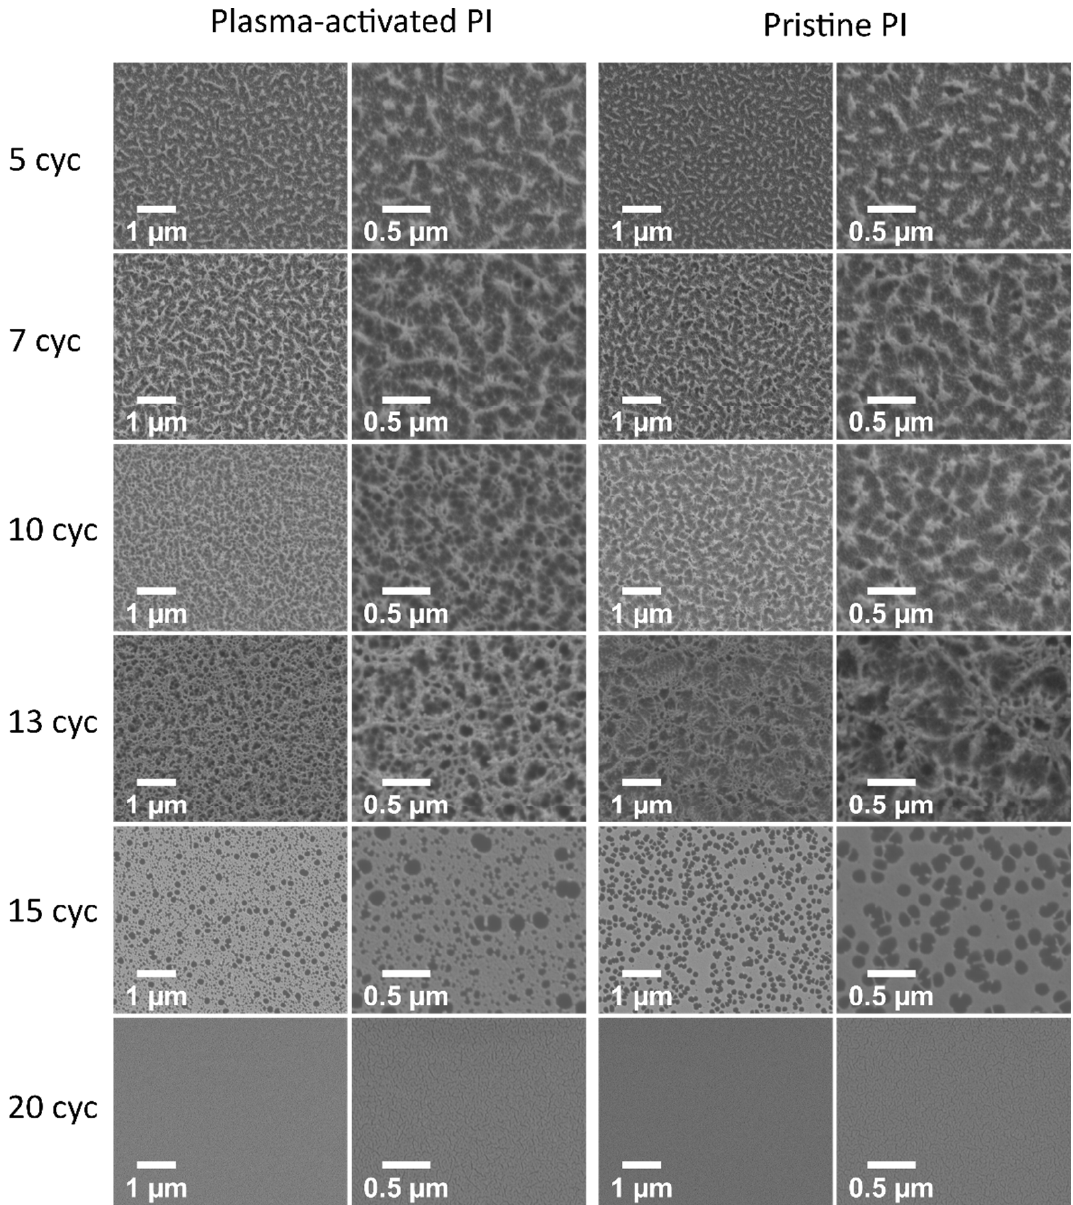
Figure 7. FEG–SEM images showing the evolution of Al 2 O 3 ALD nucleation on plasma-activated polyimide and pristine polyimide.